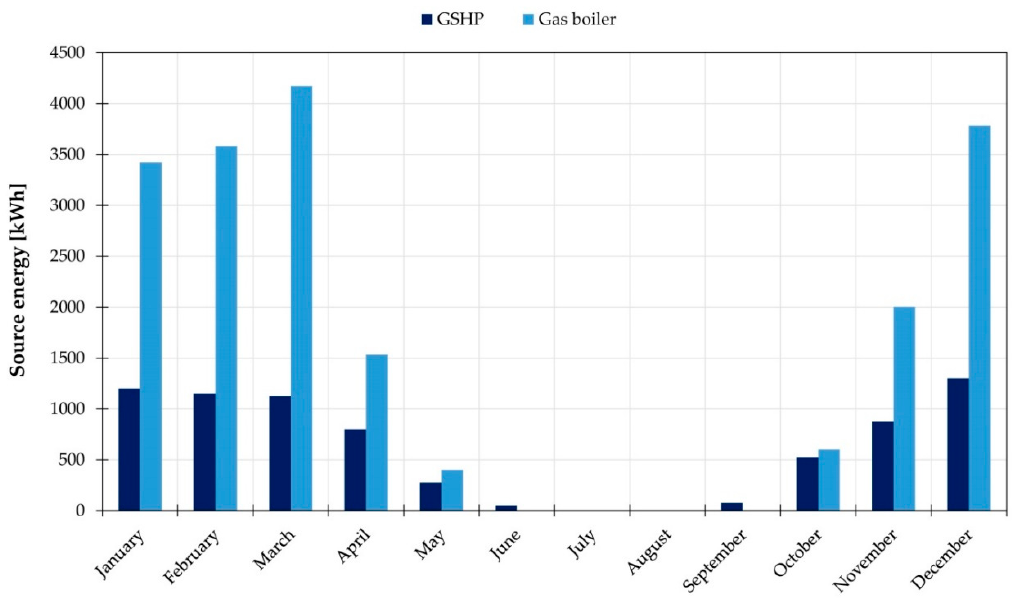
Figure 12. Building heating energy saving in terms of monthly source energy demand with the ground source heat pump system compared to the gas boiler.